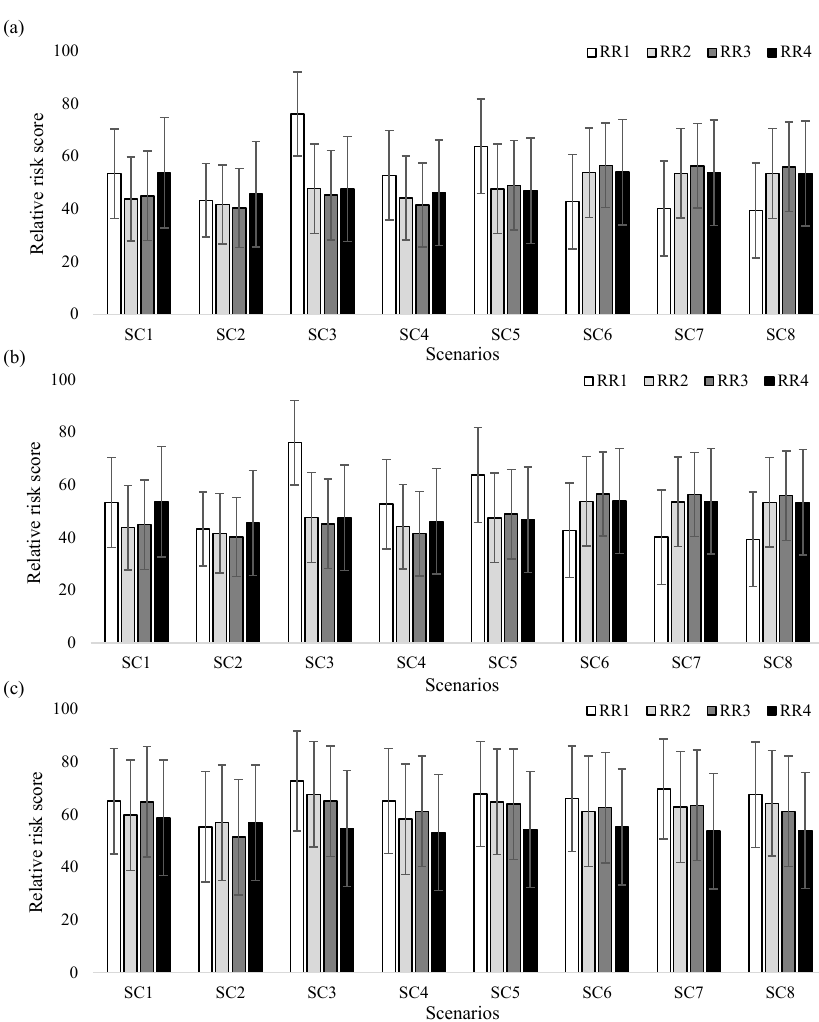
Figure 7. Senqu River case study mean relative risk scores (with SD) considered in the assessment including relative risk to: riparian vegetation (a) , macro-invertebrates (b) and fish (c) wellbeing endpoints for the four risk regions per scenario